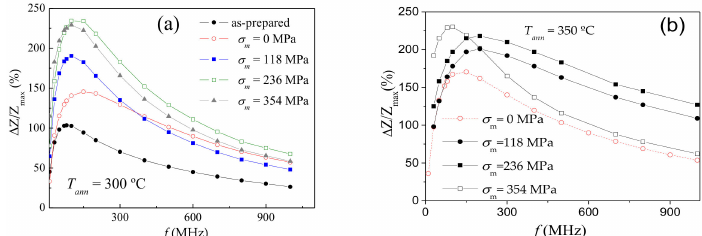
Figure 6. Frequency dependence of maximum GMI ratio, ∆ Z / Z max , in as-prepared and stress-annealed at T ann = 300 ◦ C ( a ) and T ann = 350 ◦ C ( b ) Co 69.2 Fe 3.6 Ni 1 B 12.5 Si 11 C 1.2 Mo 1.5 microwires.